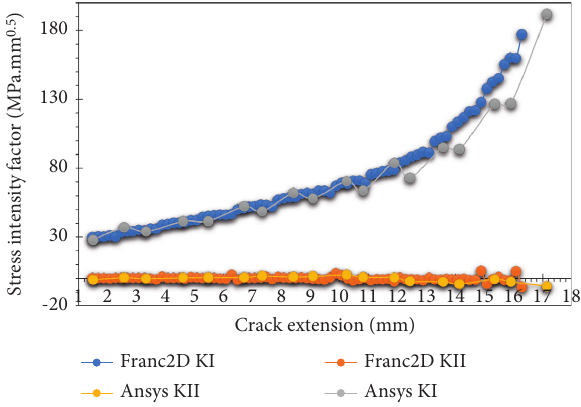
Figure 13: Stress intensity factors with corresponding crack length for CT01 specimen.